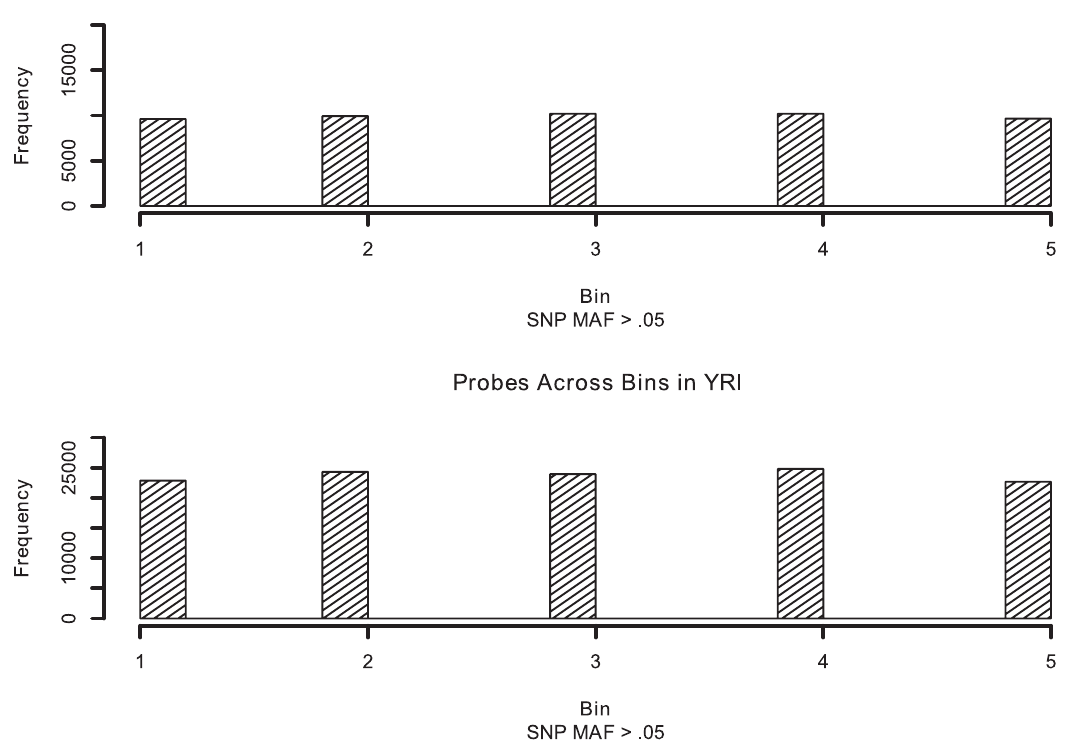
Figure 2. Distribution of SNP locations with the 25-mer exon array probes. Each bin is 5 nt. Left is 5 9 and right is 3 9 . Common SNPs (MAF . 0.05) are included. MAF: minor allele frequency. doi:10.1371/journal.pone.0009366.g002 PLoS ONE |